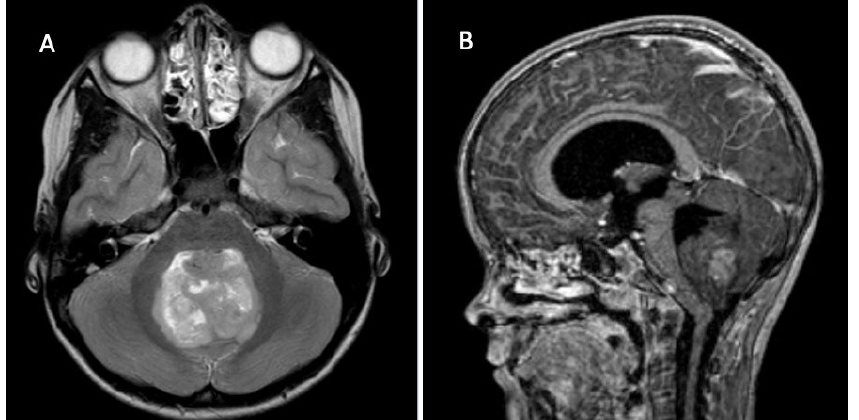
Figure 2. 7 year old girl with signs of raised intracranial pressure and ataxia. ( A ) Axial T2 MRI shows midline tumor in the posterior fossa with IVth ventricle compression. ( B ) Sagittal contrasted T1 MRI with partially enhancing tumor and associated hydrocephalus. Diagnosis: Medulloblastoma, non- WNT/non-SHH (WHO grade